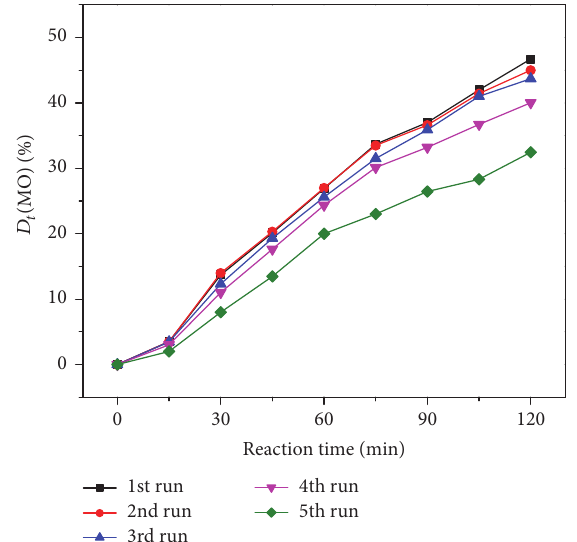
Figure 8: 𝐷 𝑡 (MO) of reaction time referring to CN G /TiO 2 under different reaction times under 254 nm at